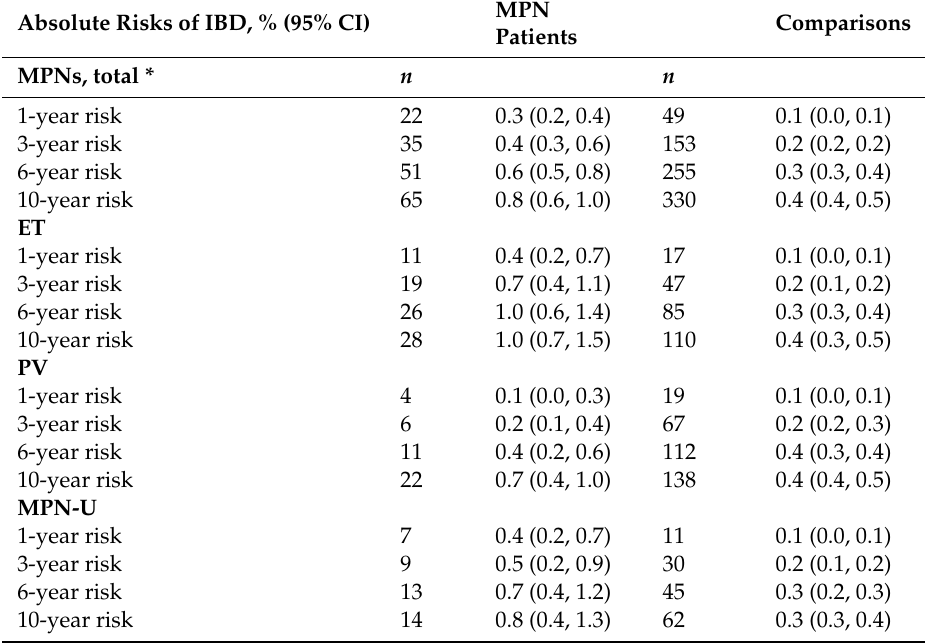
Table 2. Absolute risks of IBD among patients with myeloproliferative neoplasms (essential thrombocythemia, polycythemia vera, myelofibrosis, and unclassifiable myeloproliferative neoplasms) and their matched comparison cohorts between 1994 and 2013. MPN Absolute Risks of IBD, % (95% CI) Patients